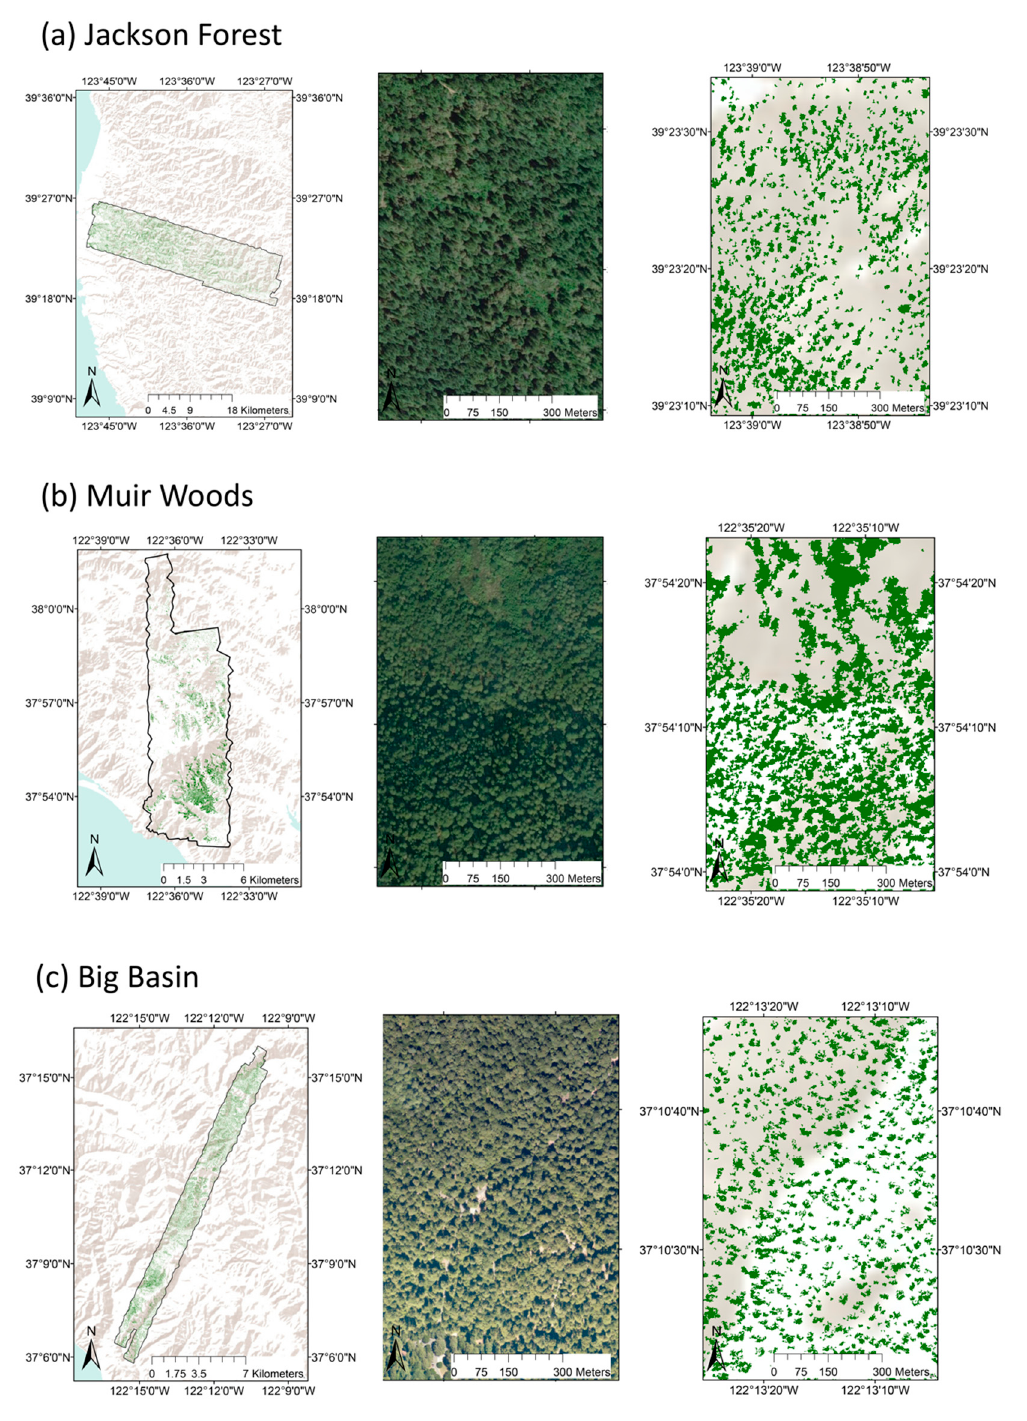
Figure 6. Mapped redwood canopies for the three study sites. Canopies are shown mapped across the site ( left column ), and then shown in close-ups as google earth imagery ( middle column ), and then pixels identified by the model in the right column at the same location and resolution as the google earth imagery.